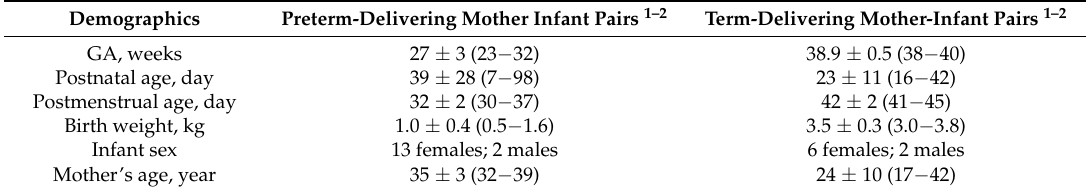
Table 1. Demographics of preterm- and term-delivering mother-infant pairs sampled for human milk and gastric contents at 2 h